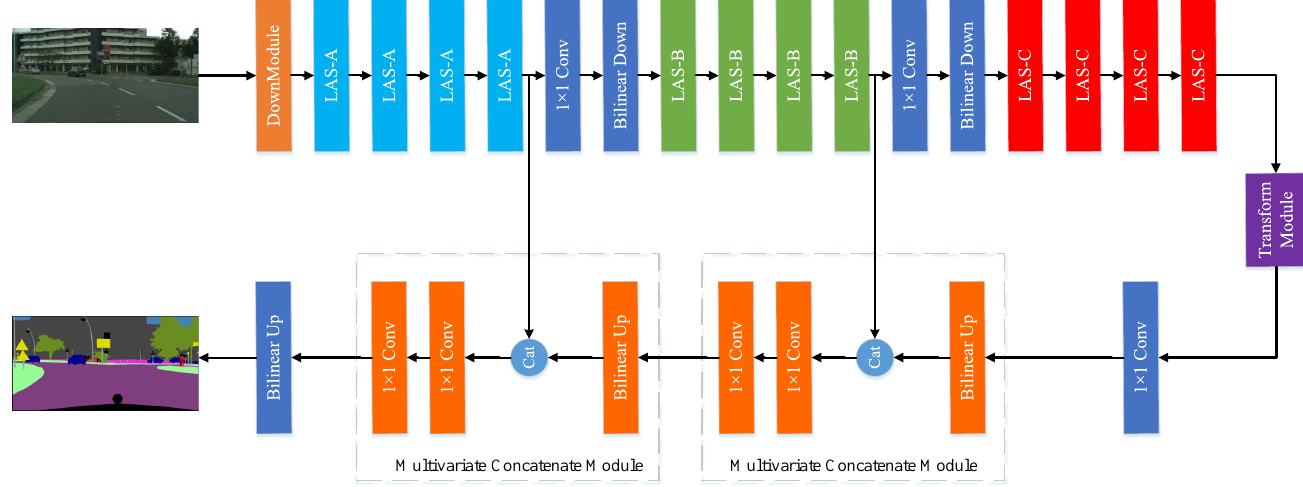
Figure 2. Detailed architecture of